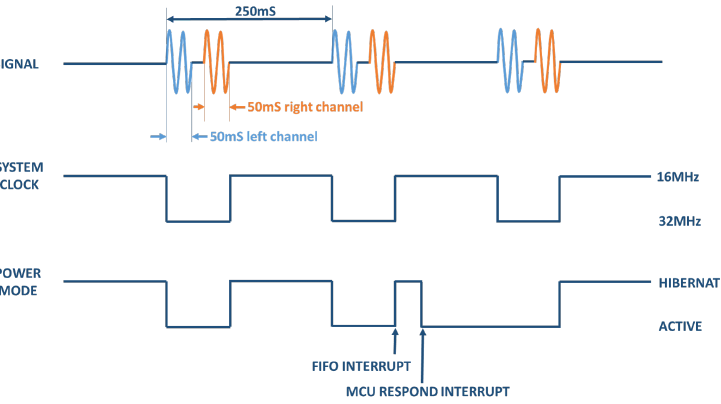
Figure 10. EDA measurement process. A complete cycle, including multiplexing and reading of the left (blue) and right (orange) channels, is completed in 250 ms–150 ms of which, approximately, the system remains hibernated. See text for further details. The interrupt signals correspond to the reaching of the FIFO memory threshold and the time at which the MCU receives the stored